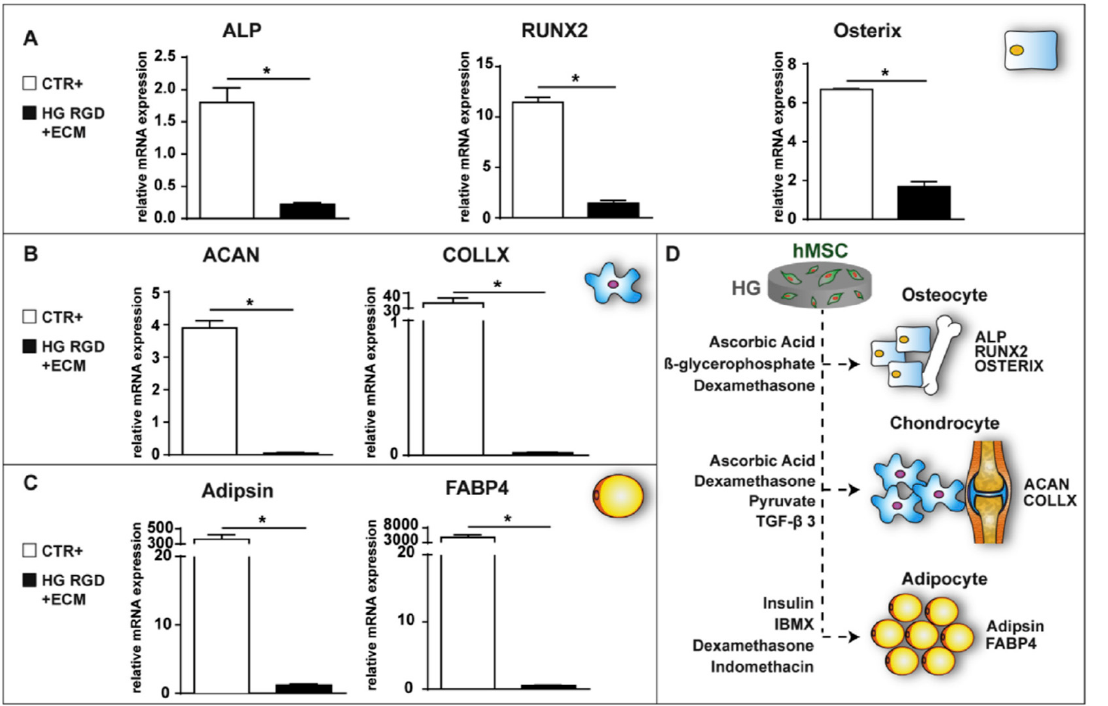
Figure 2. mRNA analysis of mesenchymal stem cells encapsulated within an agarose–Carbomer HG. ( A – C ) Graphs representing the expression of specific genes related to three differentiation lineages: alkaline phosphatase (ALP), runt-related transcription factor 2 (RUNX2), and osterix for osteogenic differentiation; aggrecan (ACAN) and collagen type X (COLLX) for chondrogenic differentiation; and adipsin and fatty-acid-binding protein 4 (FABP4) for adipogenic differentiation. Stem cells encapsulated within the HG for 21 days are compared to the positive control, represented by stem cells loaded in the HG and treated with specific differentiating media for 21 days. Data are expressed as the fold change compared to steady-state undifferentiated stem cells (negative control). ( D ) A representative cartoon of the three lineage commitments of stem cells (osteocytes, chondrocytes, and adipocytes), with respective principal pro-differentiating stimuli: ascorbic acid, b-glycerophosphate, and dexamethasone to induce osteogenic differentiation; ascorbic acid, dexamethasone, pyruvate, and TGF-b 3 to induce chondrogenic differentiation; insulin, 3-isobutyl-1-methylxanthine (IBMX), dexamethasone, and indomethacin to induce adipogenic differentiation. * p < 0.05, n = 3. Reprinted with permission from